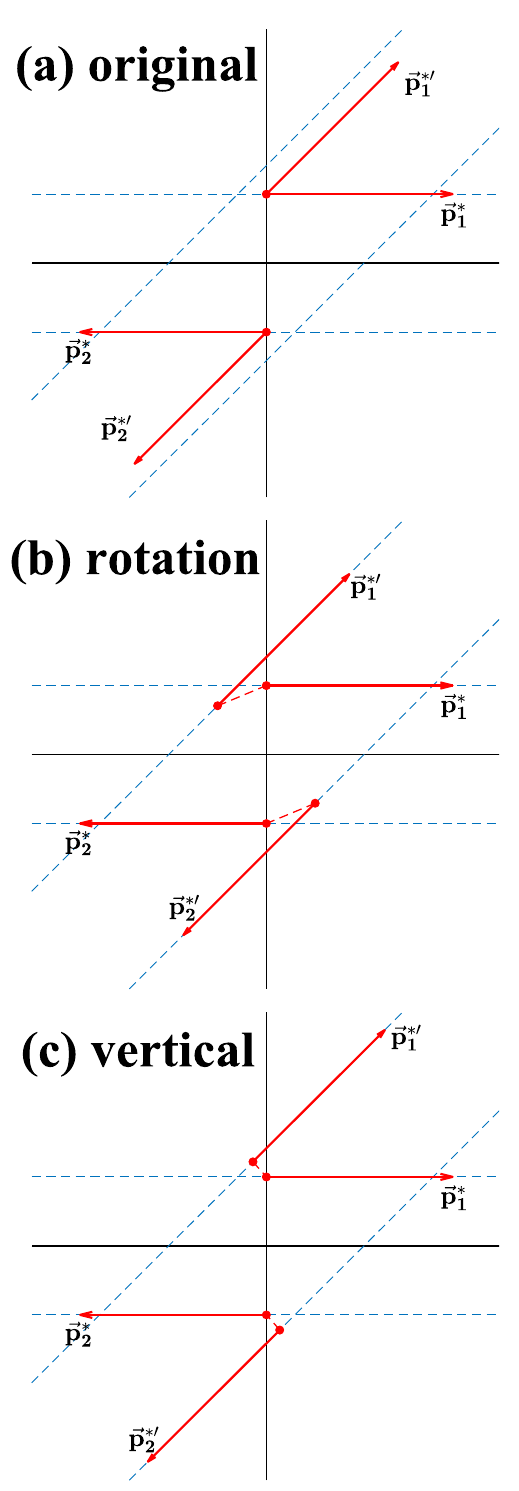
Figure 1. Cartoons for three different prescriptions in the C.M. frame of the collision. The above prescription for elastic collisions can be easily generalized to inelastic collisions. For the N + N ↔ N + ∆ channel in the present study, we have | (cid:126) p (cid:63) | (cid:54) = | (cid:126) p (cid:48) and the distance between the inclined blue dashed lines should be modified to satisfy (cid:63) (cid:63) (cid:126) r (cid:63) × (cid:126) p (cid:63) = (cid:126) r (cid:48) × (cid:126) p (cid:48) . In the ∆ → N + π process, N and π are produced at the same position as ∆ , and the angular momentum is always conserved. We are unable to conserve